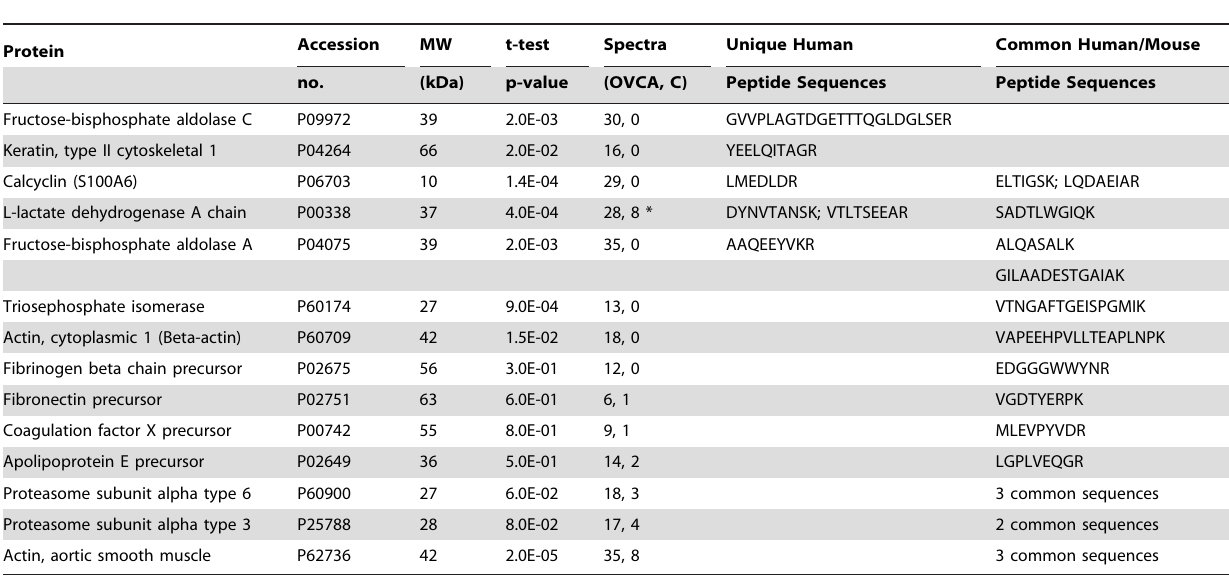
Table 1. Differentially abundant proteins in serum from OVCA and control (C) mice selected based upon spectral counting.